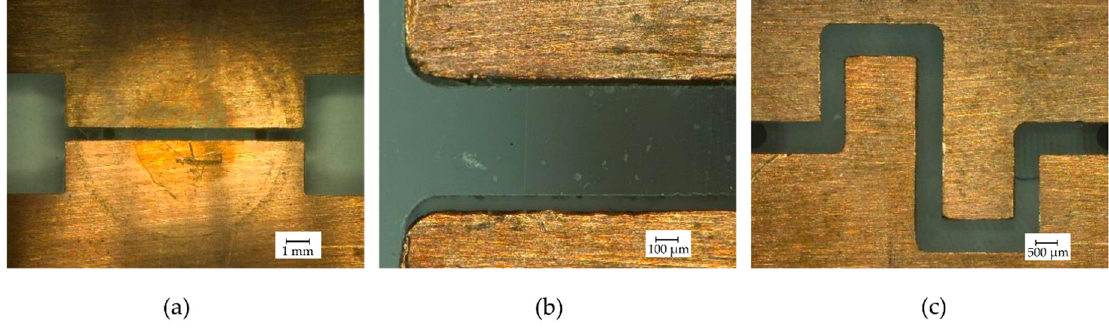
Figure 6. Experimental setup used for signal measurements from µPID prototype.